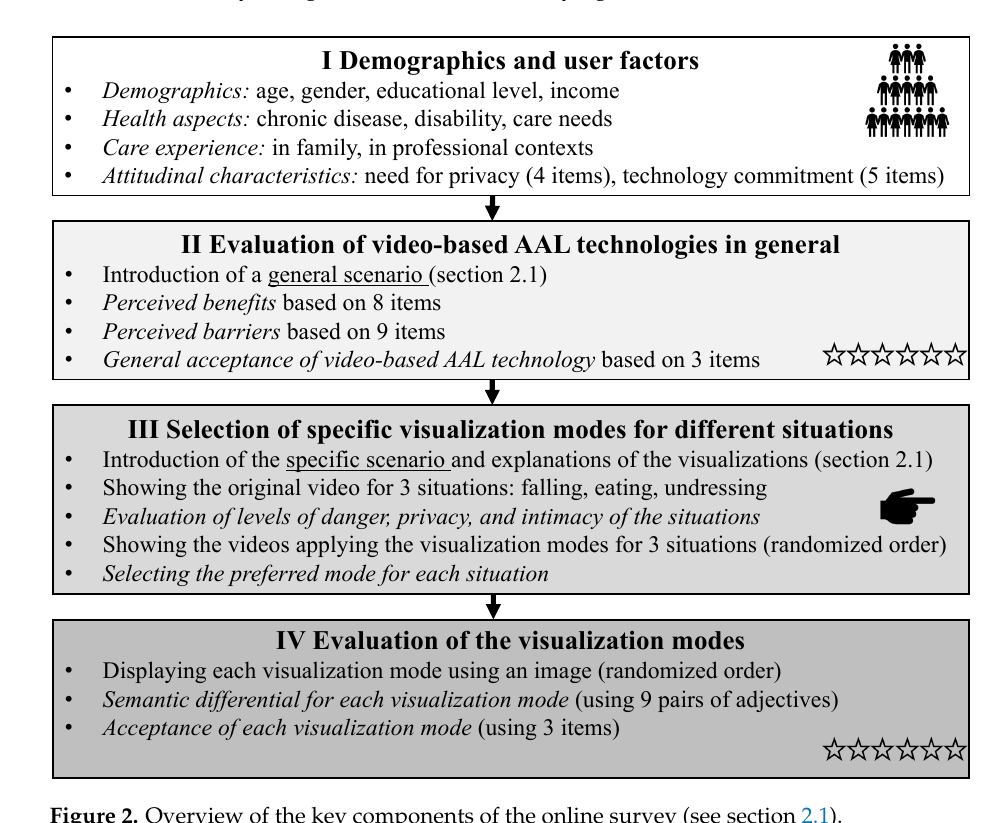
Figure 2. Overview of the key components of the online survey (see section